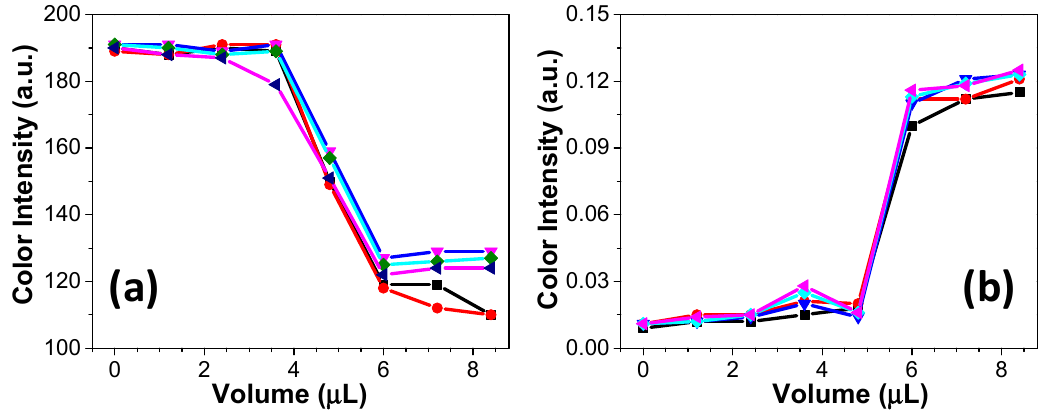
Figure 4. Titration curves performed on wax printed paper microzones showing examples of ( a ) NaOH versus HCl and ( b ) HCl versus NaOH titrations. In both examples, titrations were carried out using equimolar solutions (0.1 mol/L). For each titration, microzones were first spotted with 5 µL of the natural indicator. In (a,b), the color intensities were recorded after adding 1.2 µL aliquots of HCl and NaOH, respectively. Color intensity was captured by smartphone and analyzed through the Photometrix ® App.